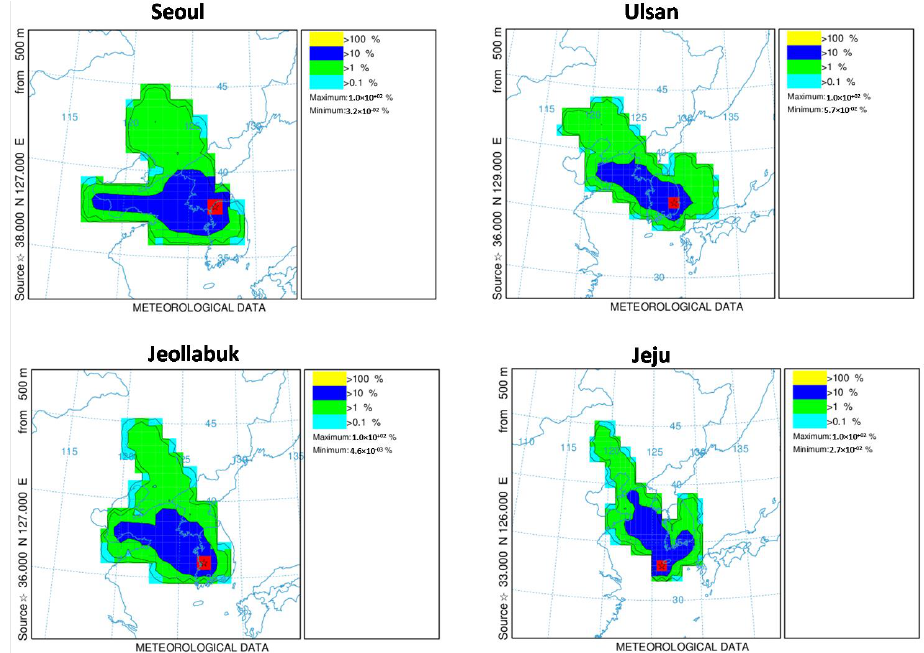
Figure 6. Trajectory frequencies (percentage of airmass transport) over the four sites during 1–15 January 2019.